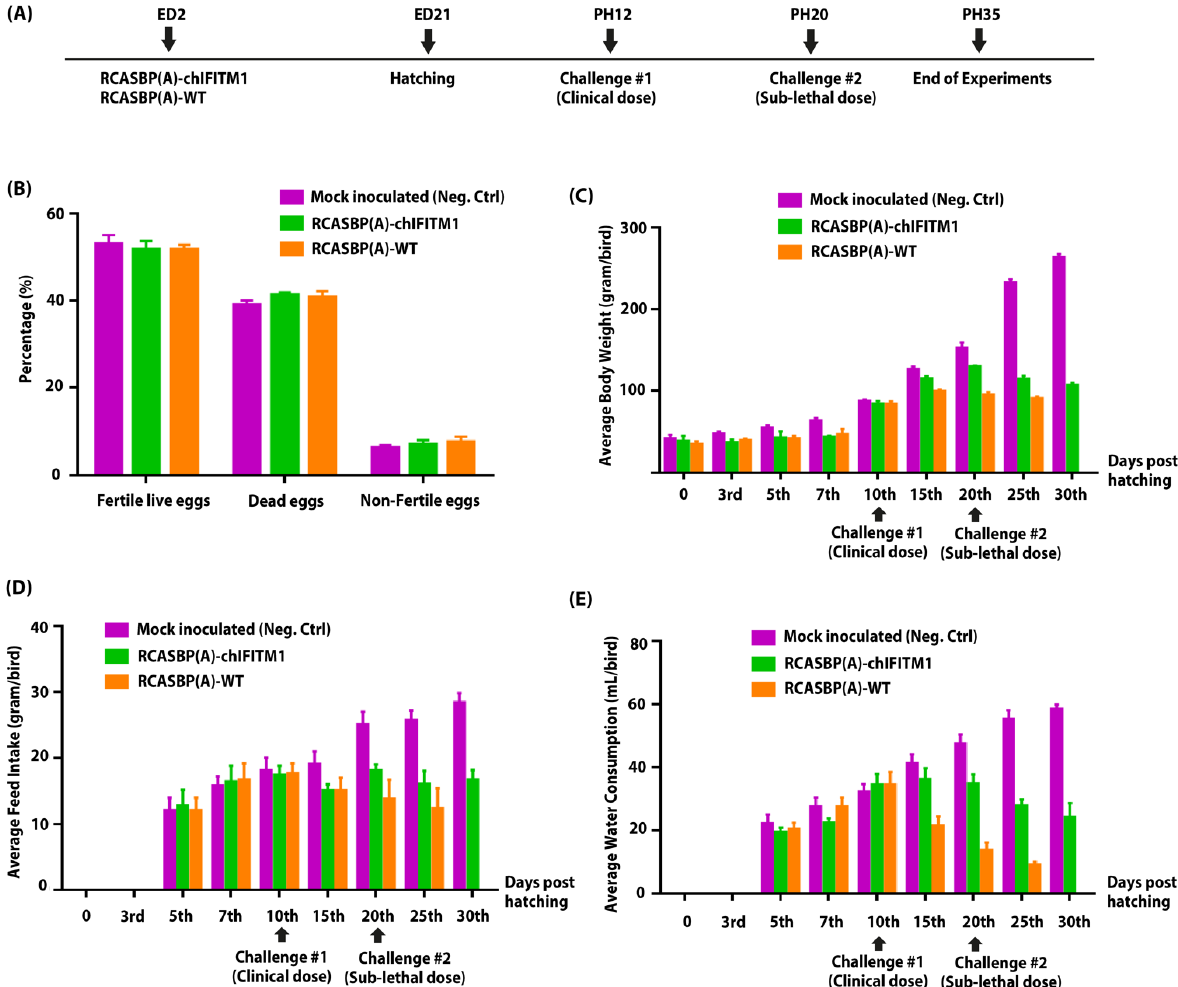
Figure 2. Generation of transgenic chickens and impact of chIFITM1 on hatchability and physiological parameters of hatched chicks. ( A ) Schema representing the time of transgenesis and challenge experiments. Comparison of hatchability percentage ( B ), body weight ( C ), feed intake ( D ), and water consumption ( E ) of chIFITM1-expressing transgenic chicken and control chicks (RCASBP(A)-WT and negative control) post-hatching (PH), pre-challenge and post-challenge. Statistical analyses between different inoculated groups were provided within Supplementary Data files 1, 2, 3, and 4. Values of p value < 0.05 were considered statistically significant.